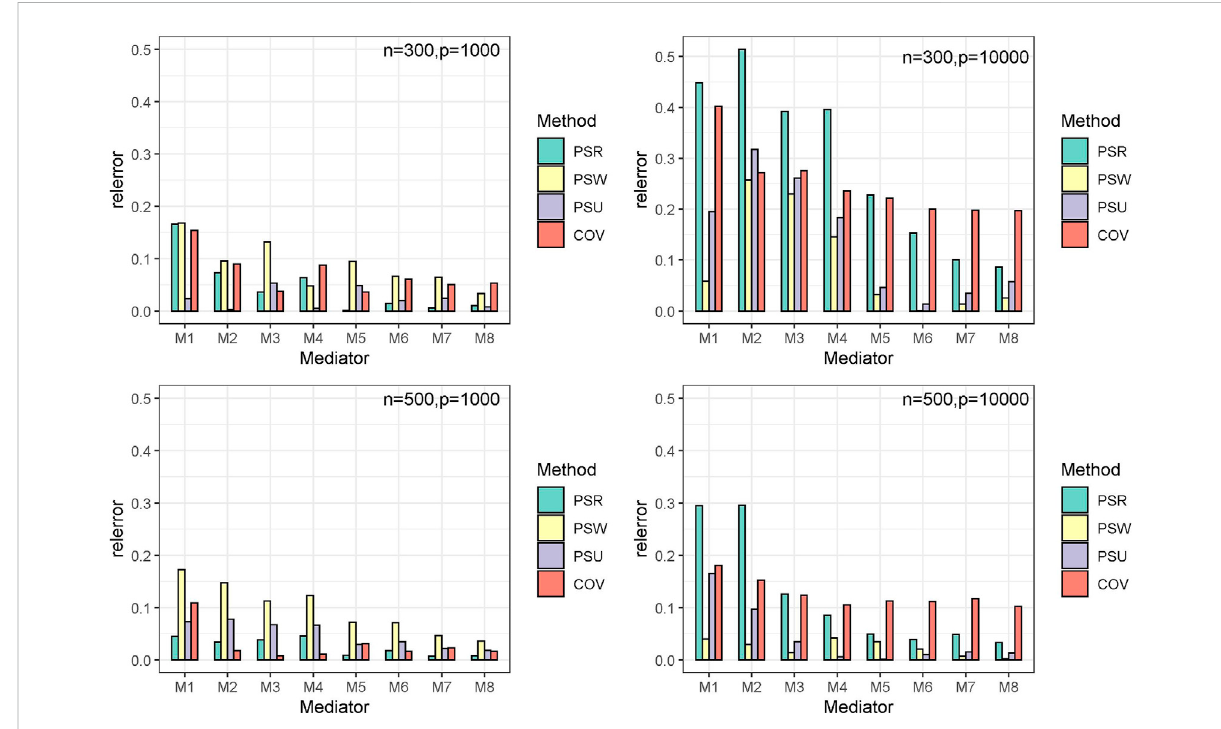
FIGURE 3 The relative estimate error for the true mediators ( α (cid:1) 0 . 6 t , β (cid:1) 0 . 4 t ). * Relativeestimateerror (cid:1) | estimatevalue – truevalue | / truevalue